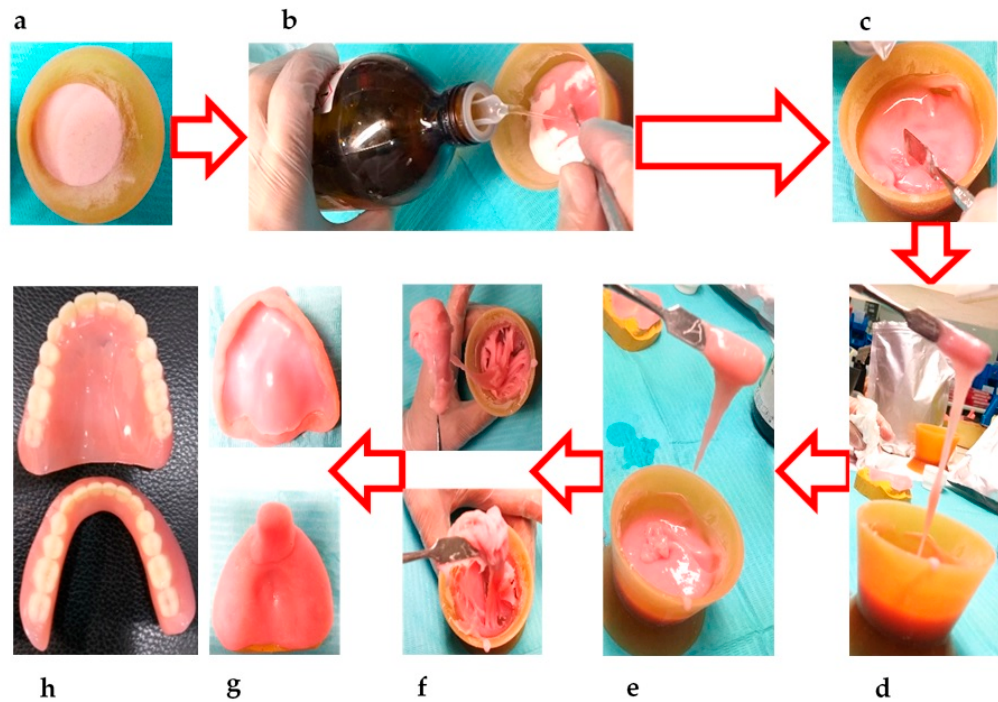
Figure 2. Manipulation and various stages of PMMA manual mixing and handling for denture fabrication: ( a ) PMMA powder in a mixing bowl; ( b ) pouring of the monomer solution into PMMA for mixing; ( c ) sandy stage, whereby the monomer solution has full wetted and saturated the PMMA particles; ( d ) start of stringy stage; ( e ) progression of the stringy stage; ( f ) dough stage ready for packing and plastic molding; ( g ) rubbery stage followed by the hardened PMMA, whereby plastic deformation is no longer possible; ( h ) fabricated denture using heat-cured PMMA and acrylic teeth after finishing and polishing.